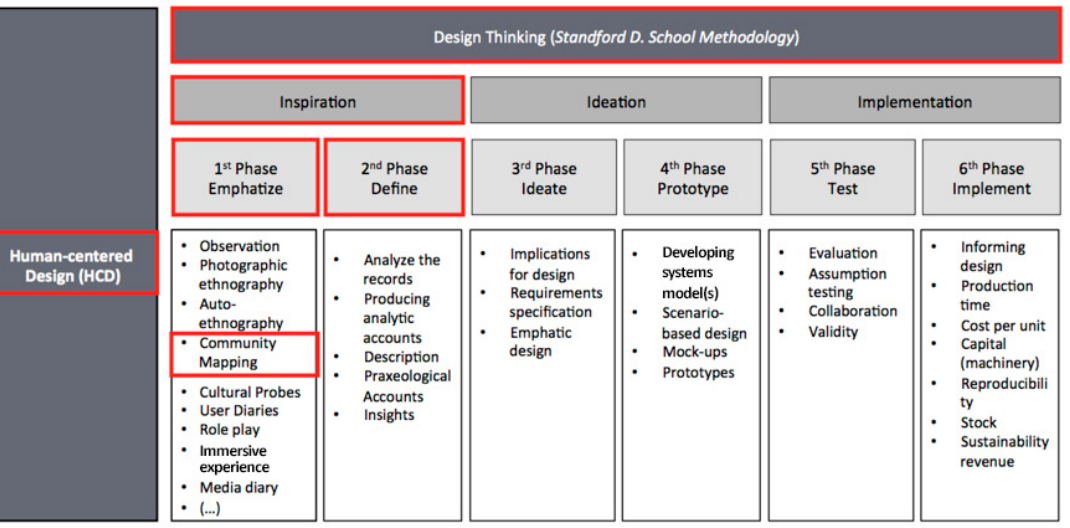
Figure 2. Human-centered design (HCD) framework characteristics. Adapted from “The field guide to Human-Centered Design” [37], “Design Thinking as an effective Toolkit for Innovation” [38], and “Doing Design Ethnography” [39].